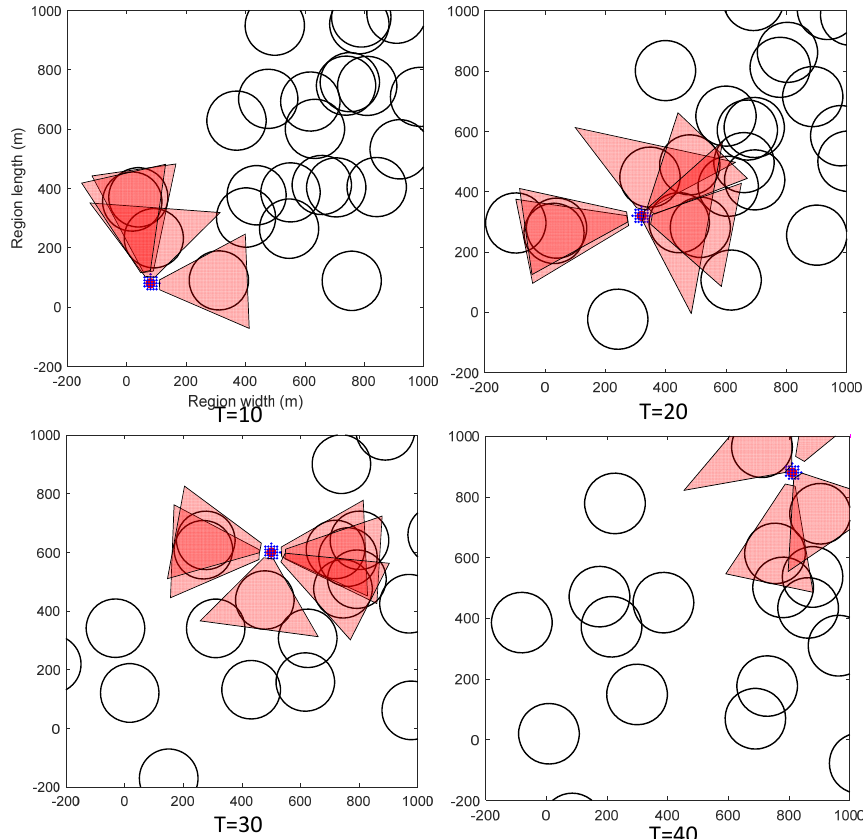
Figure 7. Four snapshots in the simulation when the MASS started from (0, 0) with destination (1000, 1000). The black circles are collision regions with other ships that should be avoided. The red cones show the